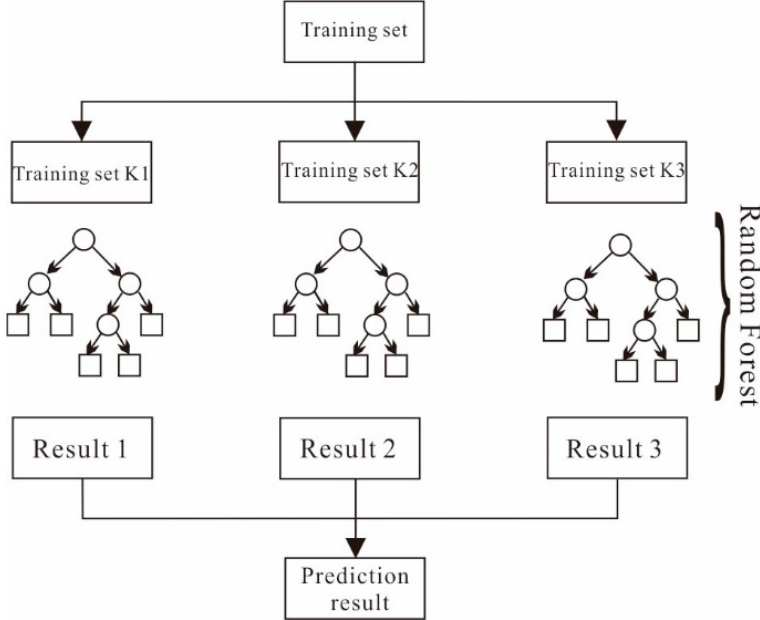
Figure 5. Schematic diagram of RF.